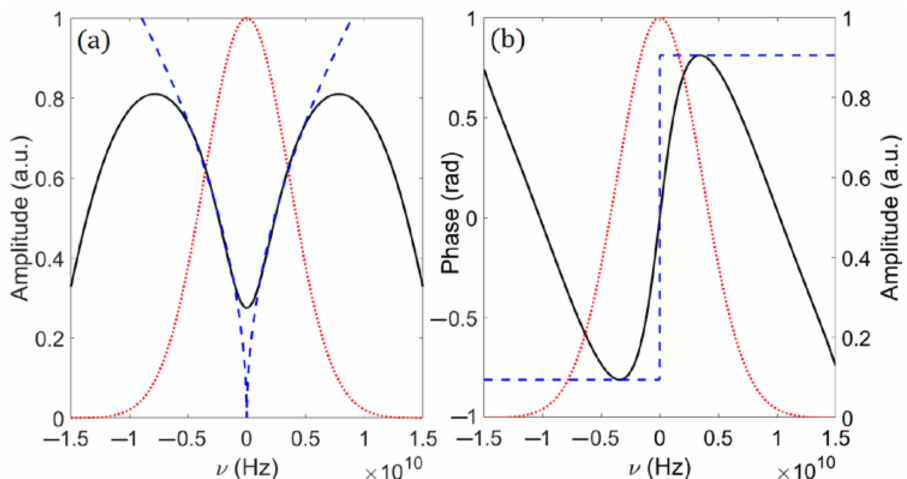
Figure 6. (Color online) Ideal (blue-dashed curve) and proposed (black-solid curve) 0.51th-order differentiator frequency response in ( a ) amplitude and ( b ) reflection phase, in baseband frequency. Amplitude (red-dotted curve) of the pulse under test is also shown in both figures normalized to unity.